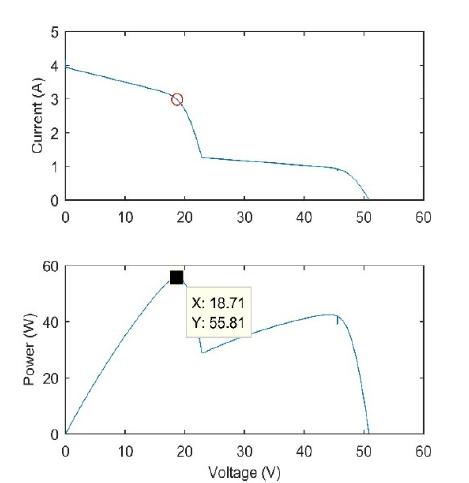
FIG. 8. GLOBAL I-V &P-V CHARACTERISTICS OF PV ARRAY IN WEAK PARTIAL SHADING CONDITION The values of the three variables voltage (V), current (I) and power (P) at MPP in a P-V characteristic curve is displayed in Fig. 8 are 18.71-Volts, 2.983-Amperes and 55.81Watt